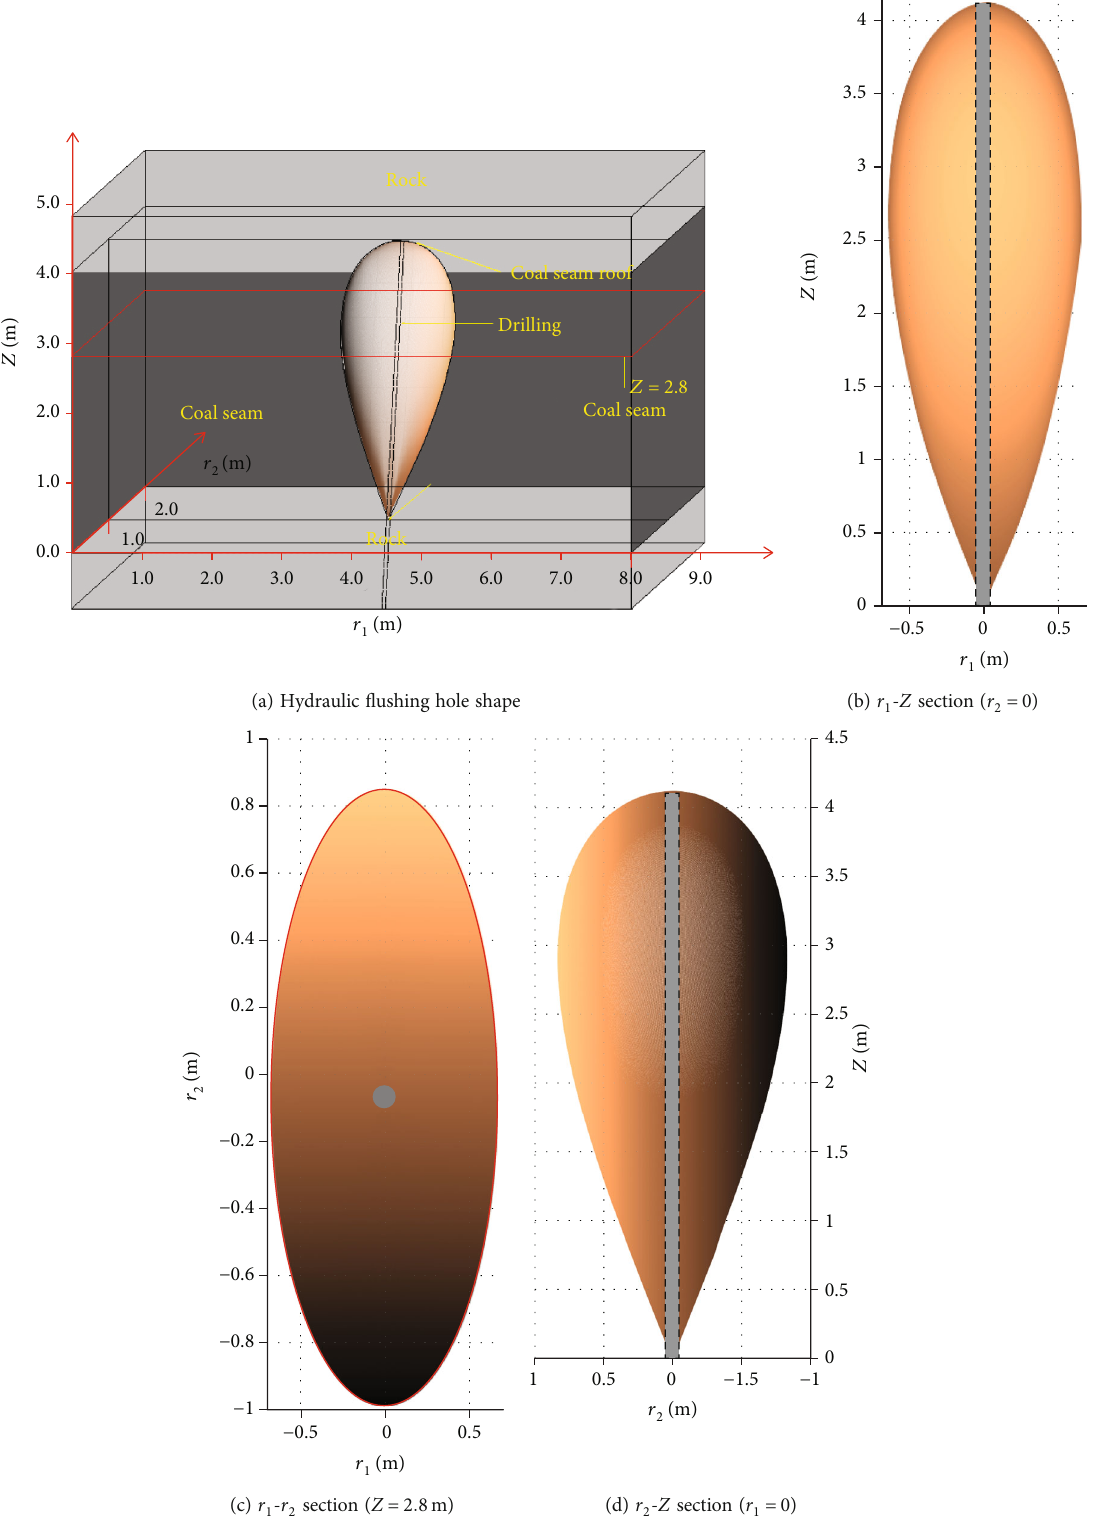
Figure 2: Pore morphology and section of hydraulic fl